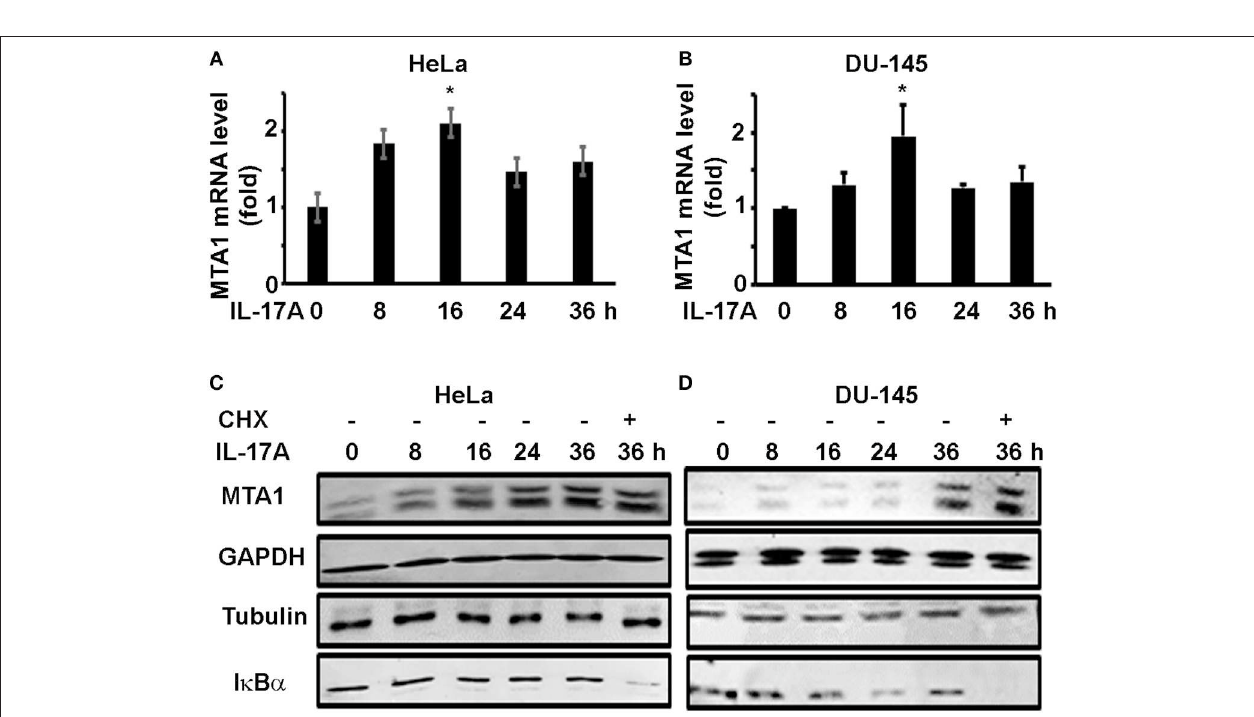
FIGURE 2 | IL-17A induces MTA1 mRNA expression in human cancer cells. HeLa and DU-145 cells were treated with 20ng/ml recombinant human IL-17A for the indicated time points. (A,B) qRT-PCR analysis of MTA1 mRNA expression; data represent mean ± standard deviation (SD, error bars) of 3 independent experiments; * p < 0.05 between the IL-17A-treated group and the time zero (untreated control) group. (C,D) Representative Western blot analysis of protein expression; the cells were treated with 20ng/ml recombinant human IL-17A for 8–36h; one group was treated with 10 µ g/ml cycloheximide (CHX) at 24h and harvested at